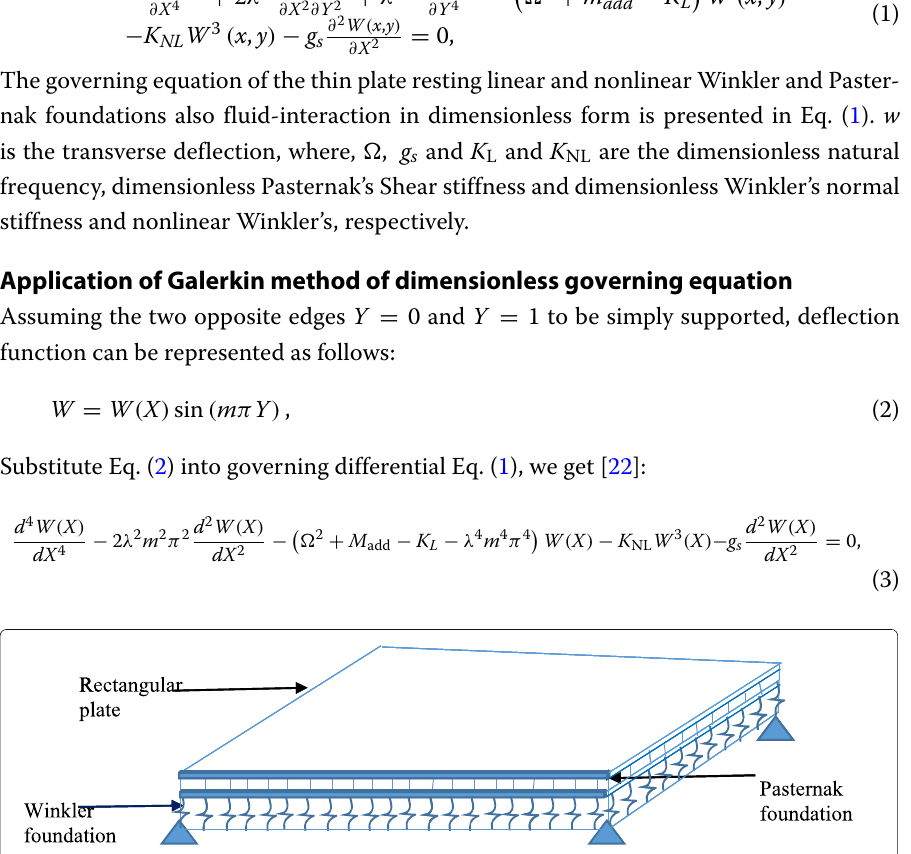
Fig. 1 Showing rectangular plate resting on the Two-Parameter